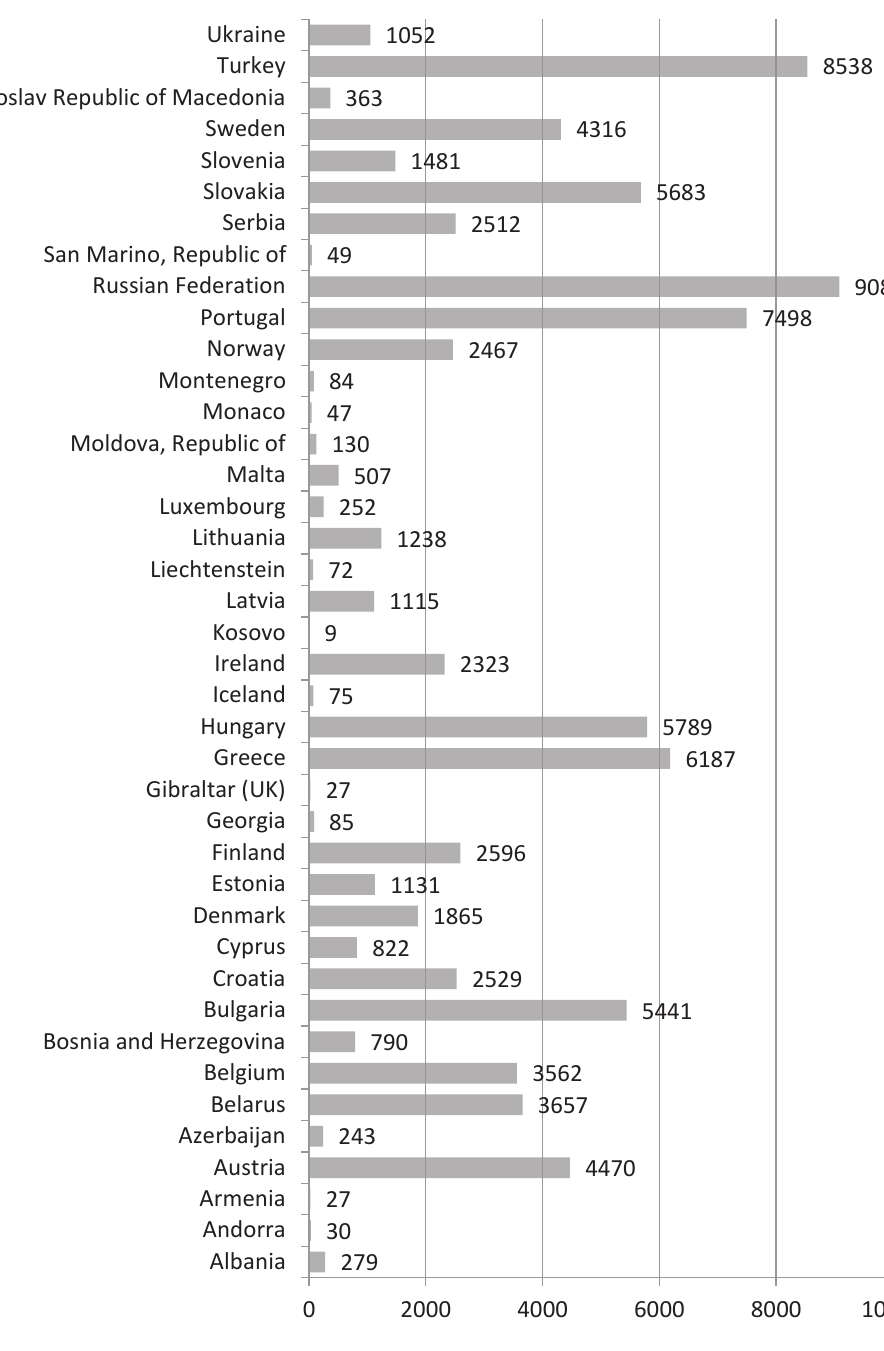
Figure 4. The number of the registered certificates in other European countries